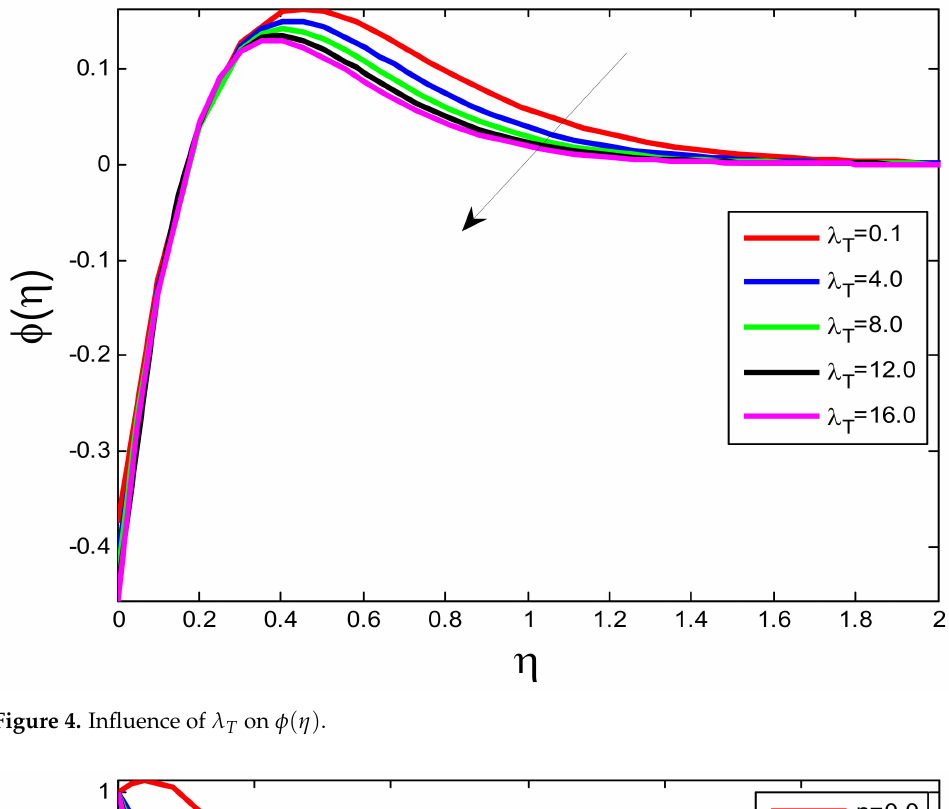
Figure 4. Influence of λ T on φ ( η ) .